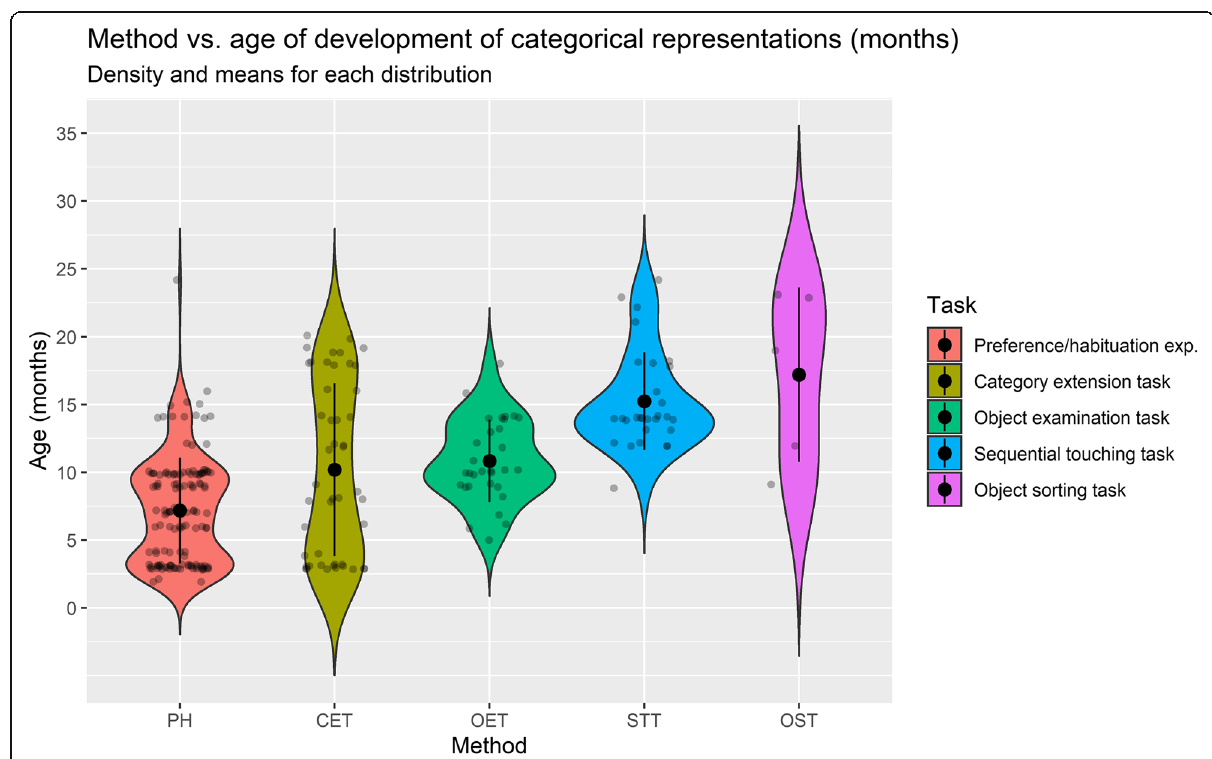
Fig. 5 Method vs age of development of categorical representations (months). Density and means for each